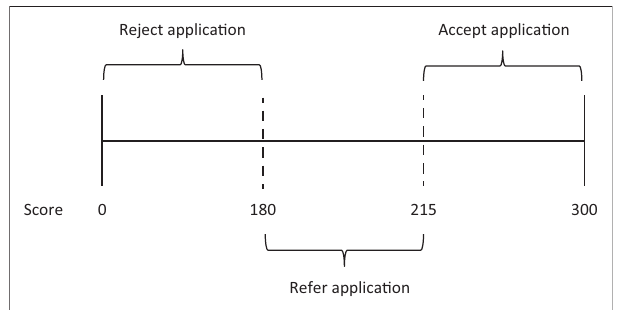
FIGURE 1: Simple cut-off score